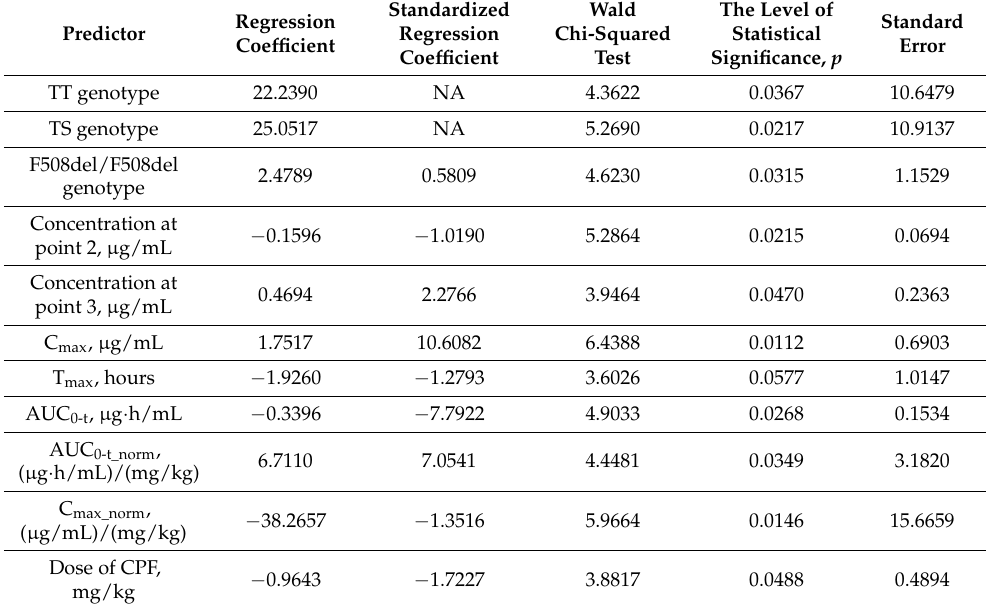
Table 17. Evaluation of logistic regression parameters in patients with different variants of the TT, TC, CC genotypes of the genetic variation of NAT2 (341T > C). Standardized Wald The Level of Regression Standard Predictor Regression Chi-Squared Statistical Coefficient Error Coefficient Test Significance, p TT genotype